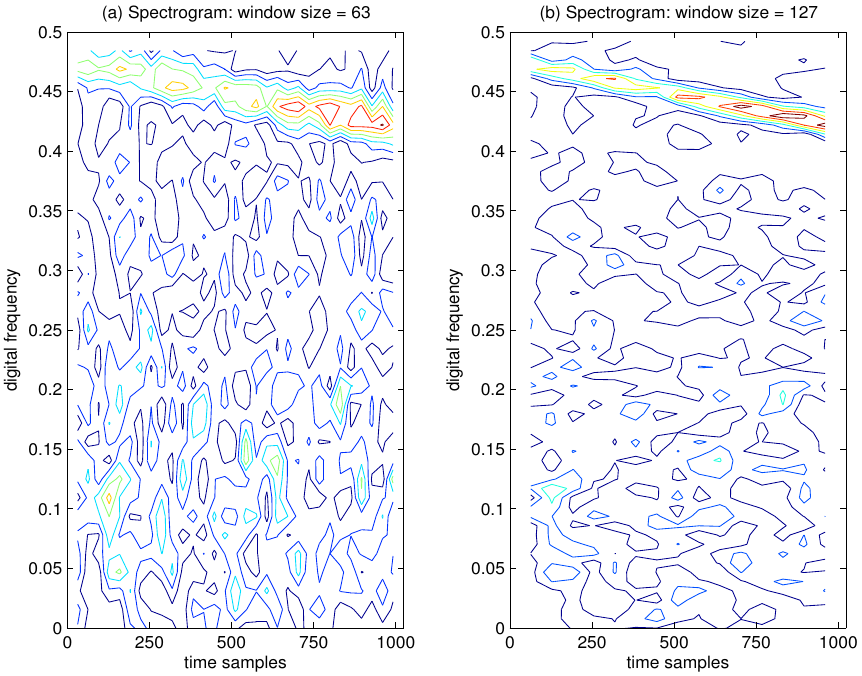
Figure 8. Spectrogram of the GPS L1 signal with sweep interference. The spectrogram has been evaluated by using a Hamming window. C/N